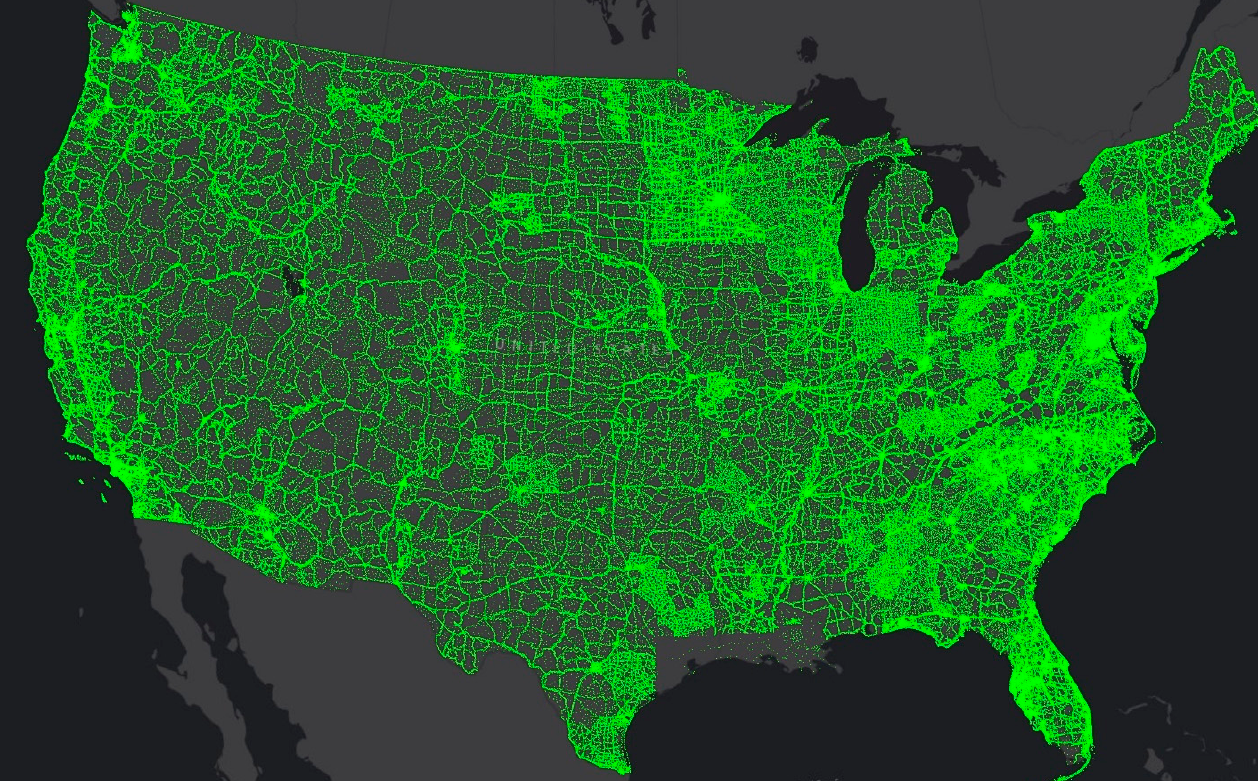
Figure 5. Locations of NGS state survey points ( n = 658,445